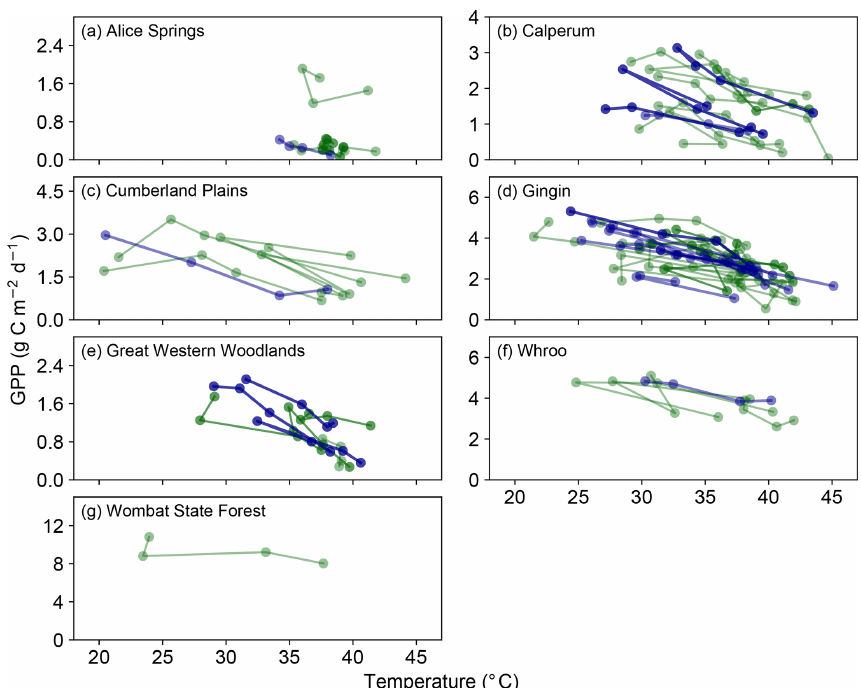
Figure 1. Evolution of GPP in the 3 days prior to and including a hot temperature extreme (daily maximum temperature exceeded 37 ◦ C). Dark blue lines represent events in which a fitted linear regression indicated a significant negative slope, whilst dark green lines represent events where the fitted slope was negative but not significant. Note in both cases that we are not showing the fitted slopes, but we are simply using this approach to identify stronger positive or negative trends in these data (see Sect. 2). Events where the fitted slope was positive are shown in Fig.